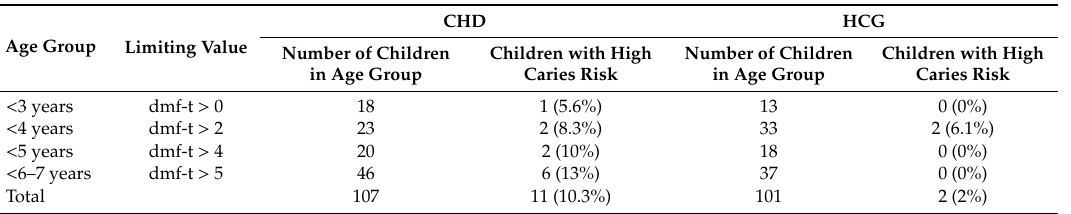
Table 2. Answers concerning the daily oral hygiene of the child with congenital heart disease (CHD) compared with the healthy control group (HCG).